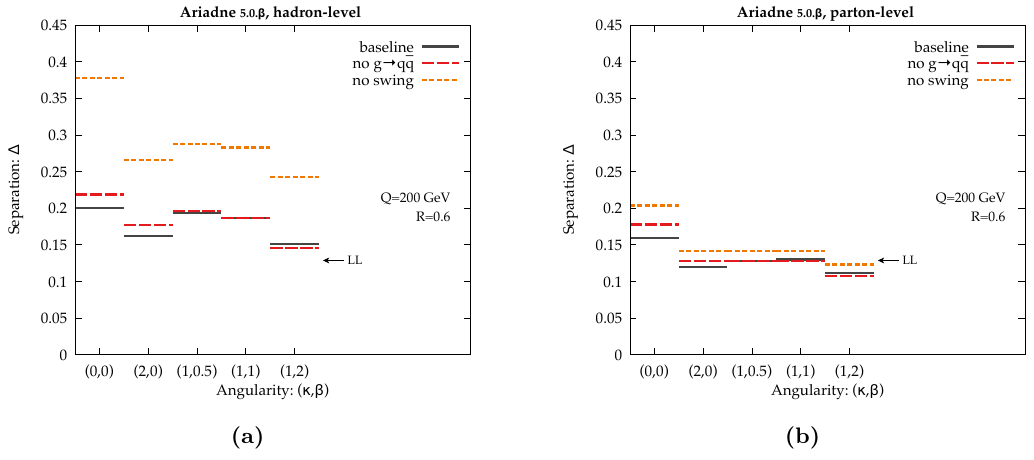
Figure 13. Same as (cid:12)gure 9, but for Ariadne 5.0. (cid:12) .